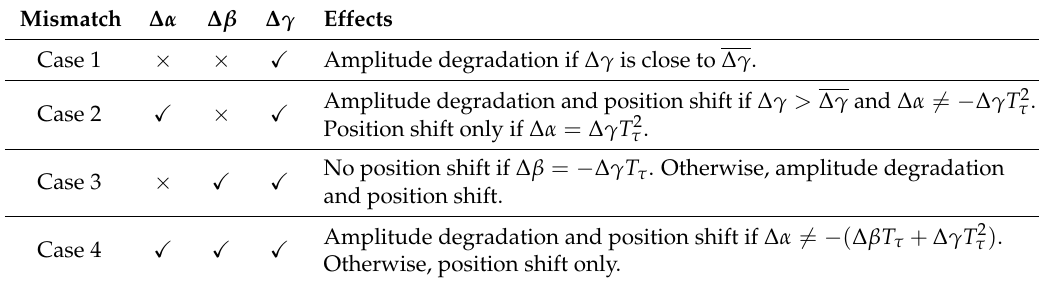
Table 1. Summary of dictionary performance. A × indicates the absence of mismatch, and a (cid:88) indicates the presence of